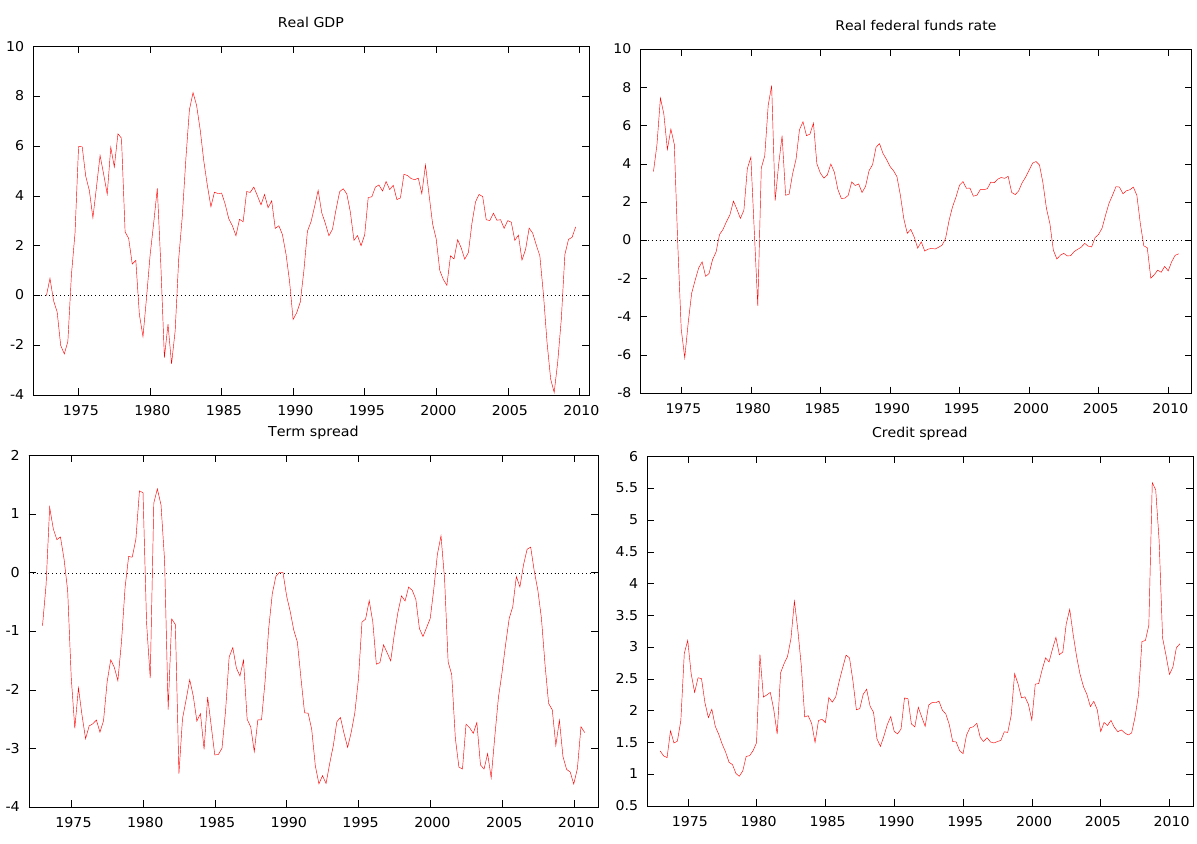
Table 1. Aggregate quarterly regression analysis. OLS-Dependent variable: ∆ y t +4 ; 1973:4–2009:4